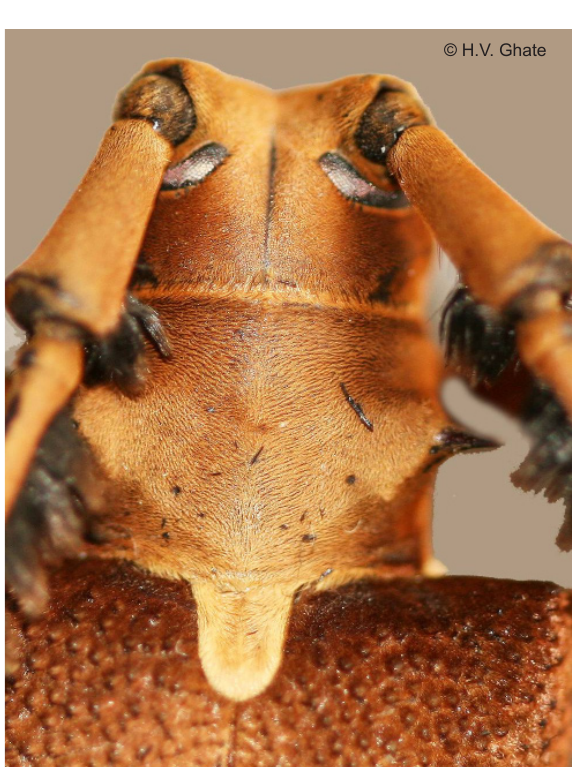
Image 5. Sarothrocera lowii White, head and pronotum,